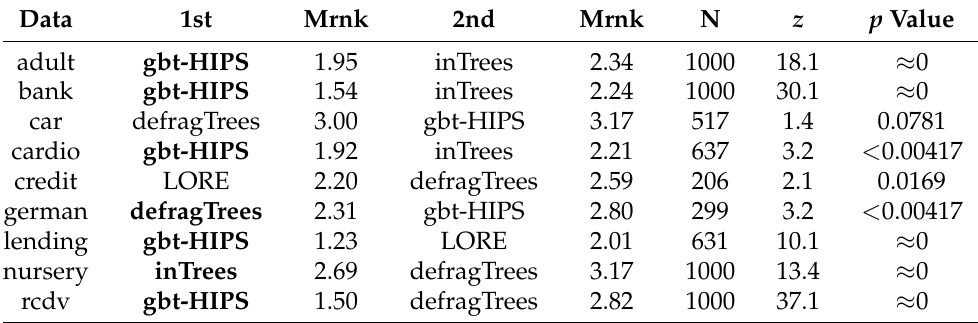
Table 5. Exclusive coverage significance tests: top two methods by mean rank (mrnk) for the stochastic GBT model.